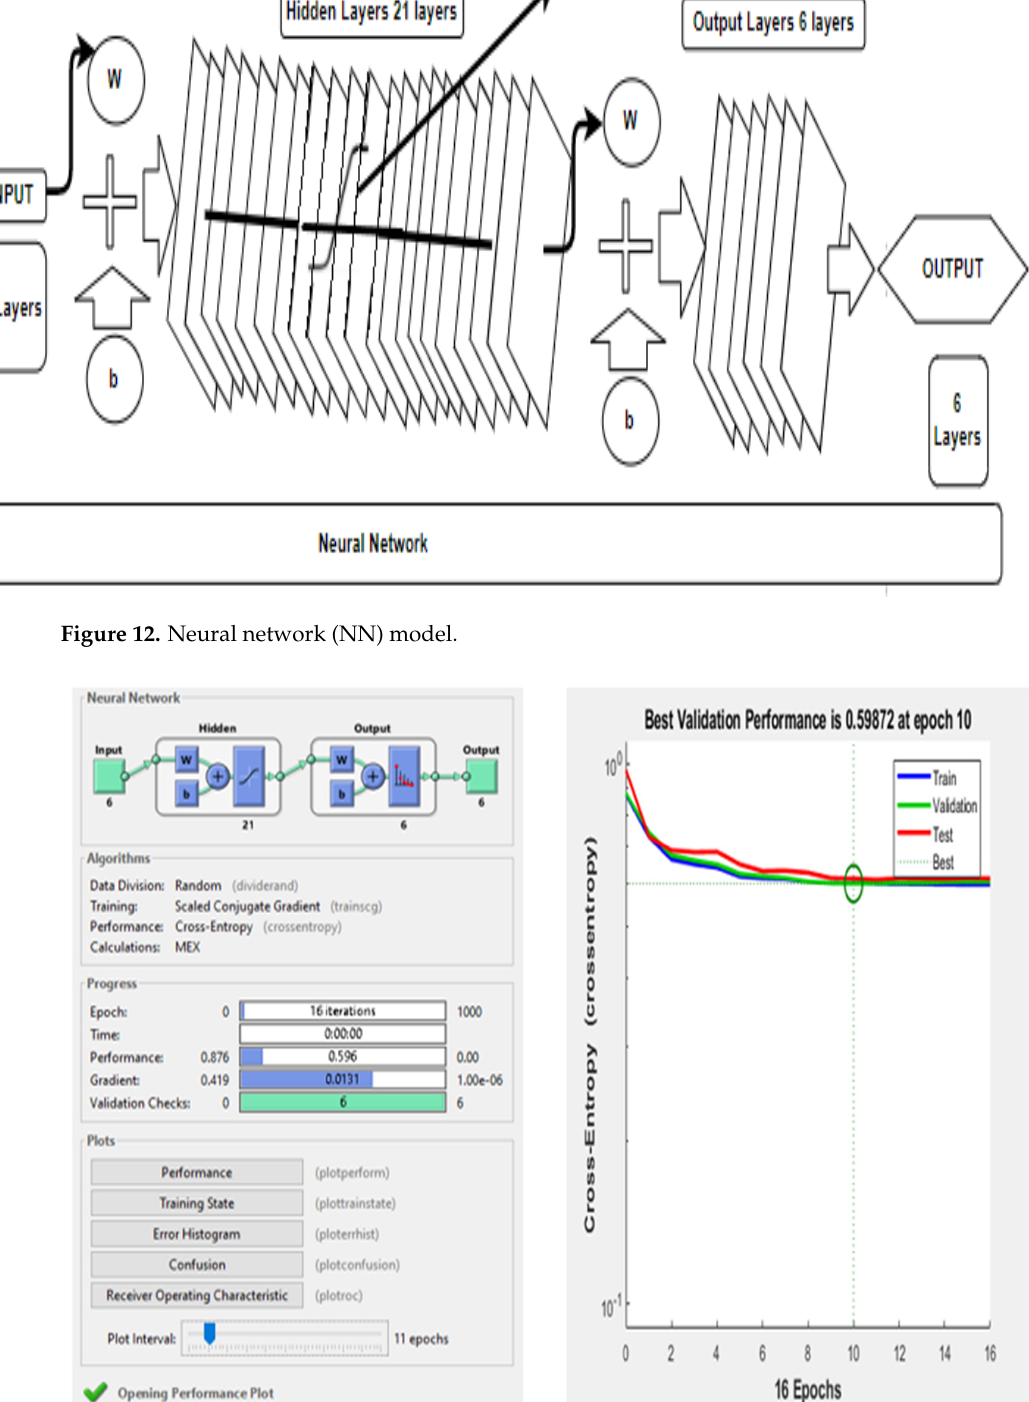
Figure 13. Neural network model performance parameters and cross-entropy error.